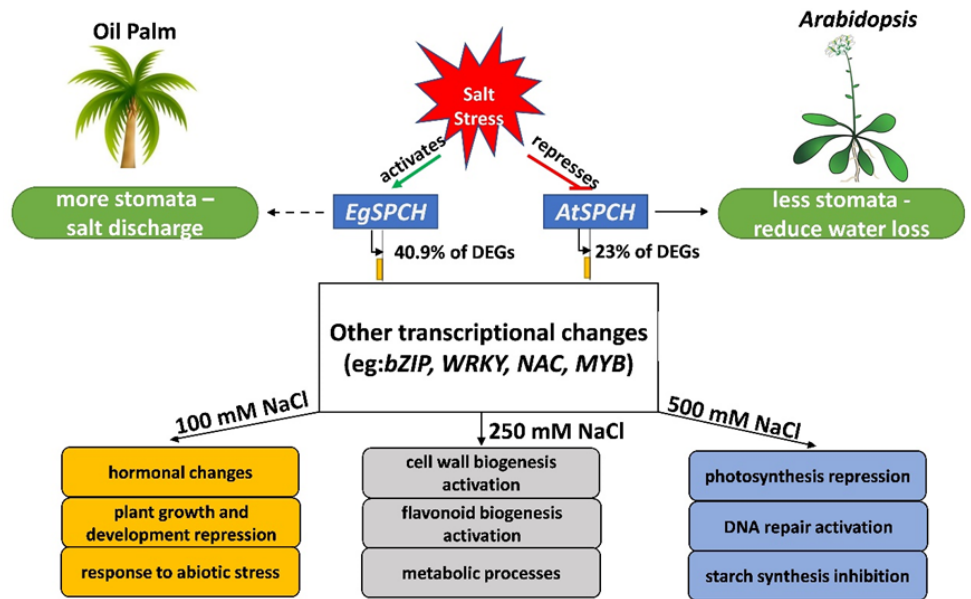
Figure 7. A proposed model of the regulatory networks of EgSPCH in response to different levels of salt stress. In contrast to Arabidopsis, where salt represses the stomatal development to reduce water loss, salt activates the transcription of EgSPCH, which directly increases the stomatal production of oil palm. EgSPCH putatively binds to ~41% of DEGs, including key transcription factors that regulate diverse biological processes. In addition, some GO items, which are involved in the known biological processes in response to salt stress, were found in different concentrations of NaCl.